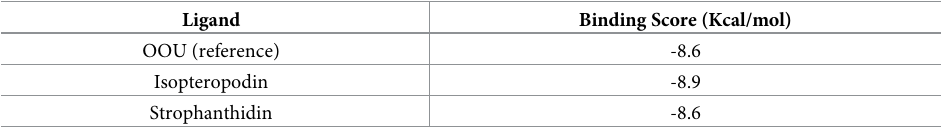
Table 3. Docking scores of ligands against the